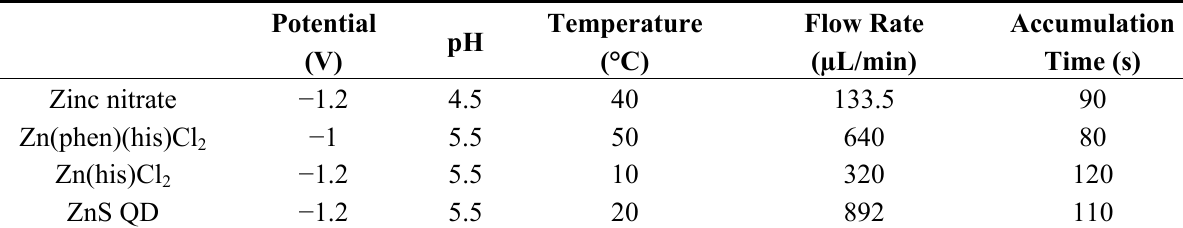
Table 1. Summary table with the optimal conditions for microfluidic